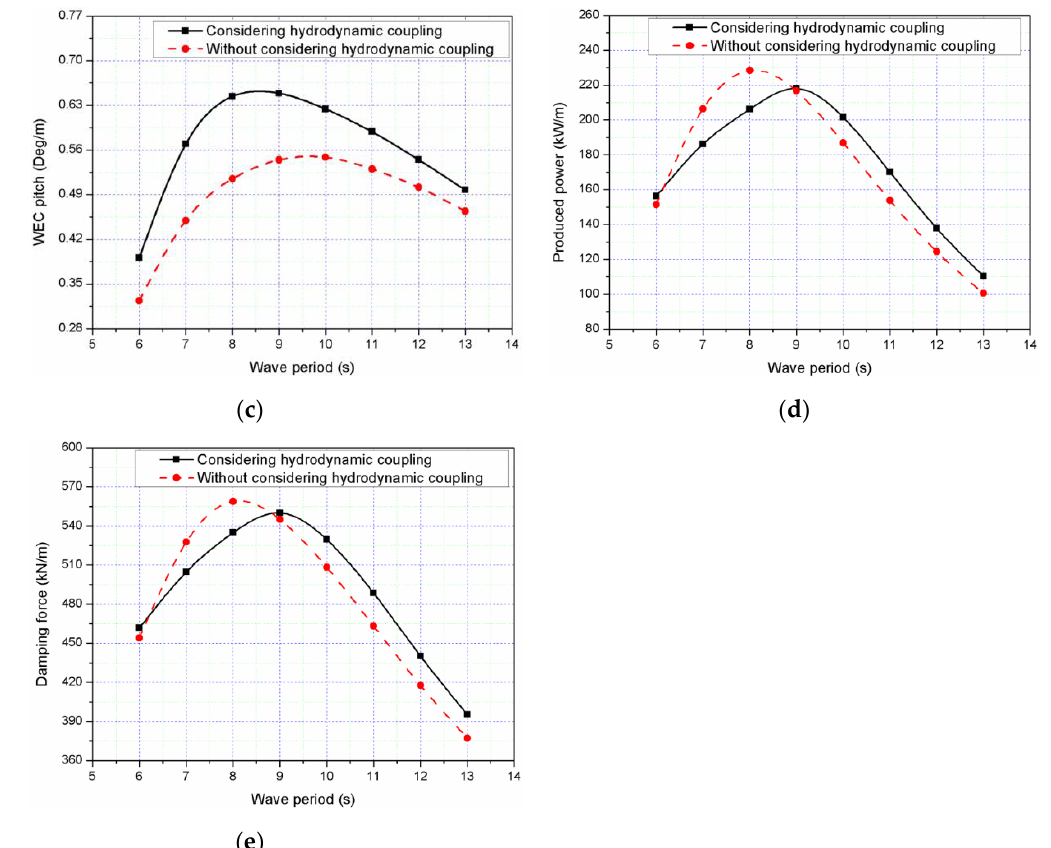
Figure 9. Comparison of responses of the combined structure between considering and without considering hydrodynamic coupling cases under different wave periods (H = 2 m): ( a ) WEC surge; ( b ) relative heave; ( c ) WEC pitch; ( d ) produced power; ( e ) damping force.